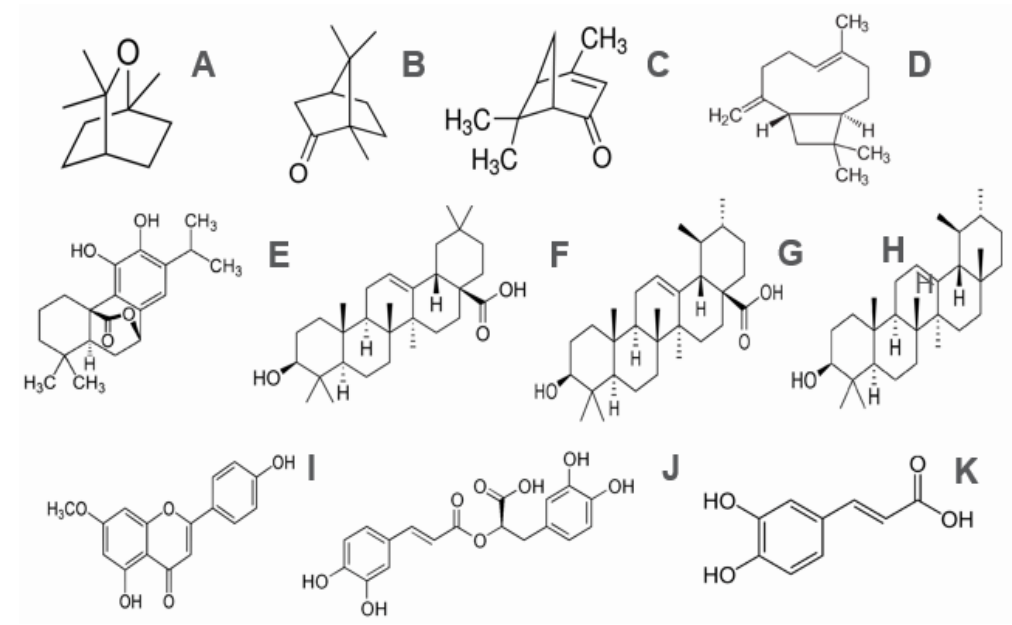
Figure 5. Structures of the main bioactive molecules in rosemary: ( A ) 1.8 cineole; ( B ) camphor; ( C ) verbenone; ( D ) β -caryophyllene; ( E ) carnosol; ( F ) oleanolic acid; ( G ) α -amyrin; ( H ) ursolic acid; ( I ) genkwanin; ( J ) rosmarinic acid; ( K ) caffeic acid.